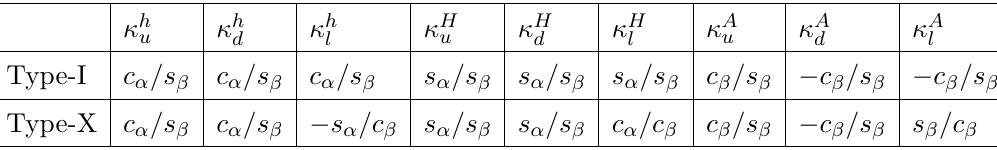
Table 1 . Higgs couplings to fermions in the 2HDM Type-I and